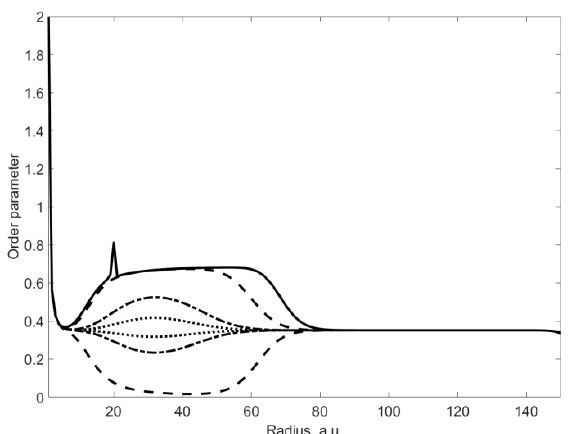
Figure 3. Dynamics of the order parameter distribution depending on the angle in the vicinity of the defect.